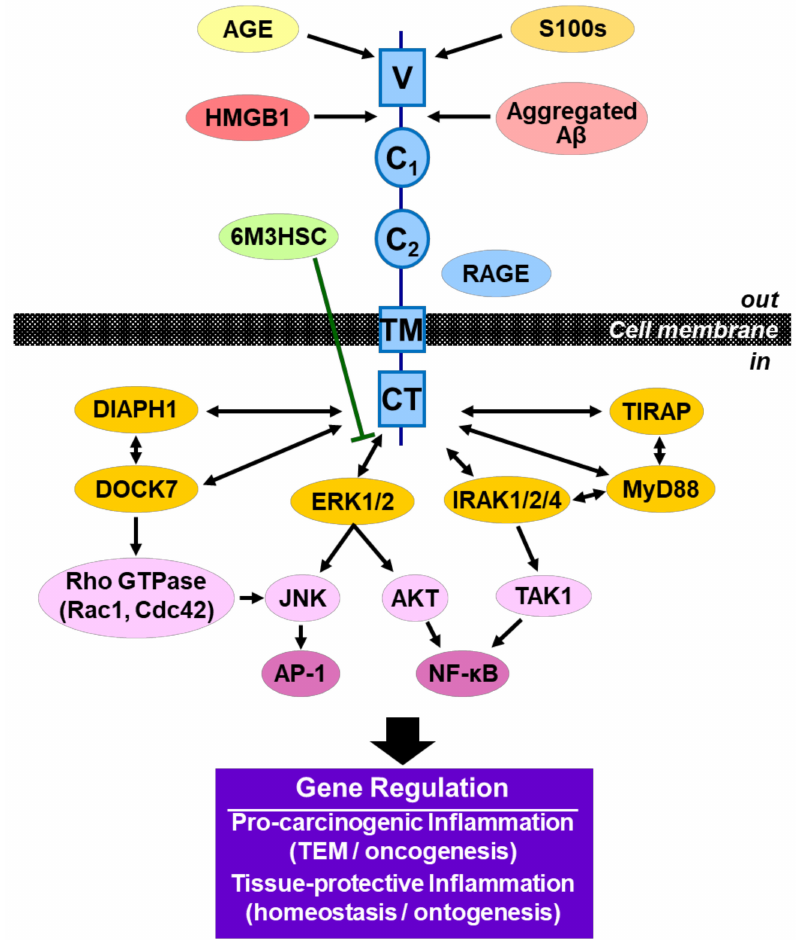
Figure 7. Schematic illustrating the suppressive effect of 6M3HSC (compound 3 ) against the RAGE- RAGE ligand signaling pathway. A potential mechanism of the suppressive effect of this compound 3 on HMGB1-RAGE-ERK 1/2 signaling pathway is shown. The interactions of multi-ligands with RAGE up-regulate the RAGE downstream signaling pathway. Consequently, RAGE-regulated genetic programs of pro-inflammation and carcinogenesis (TEM and oncogenesis) or cell repair and tissue regeneration (homeostasis and ontogenesis) start driving by the action of transcription factors, such as NF- κ B and AP-1. RAGE structure includes the variable (V), constant (C 1 and C 2 ) domains, the transmembrane region (TM), and the cytoplasmic tail